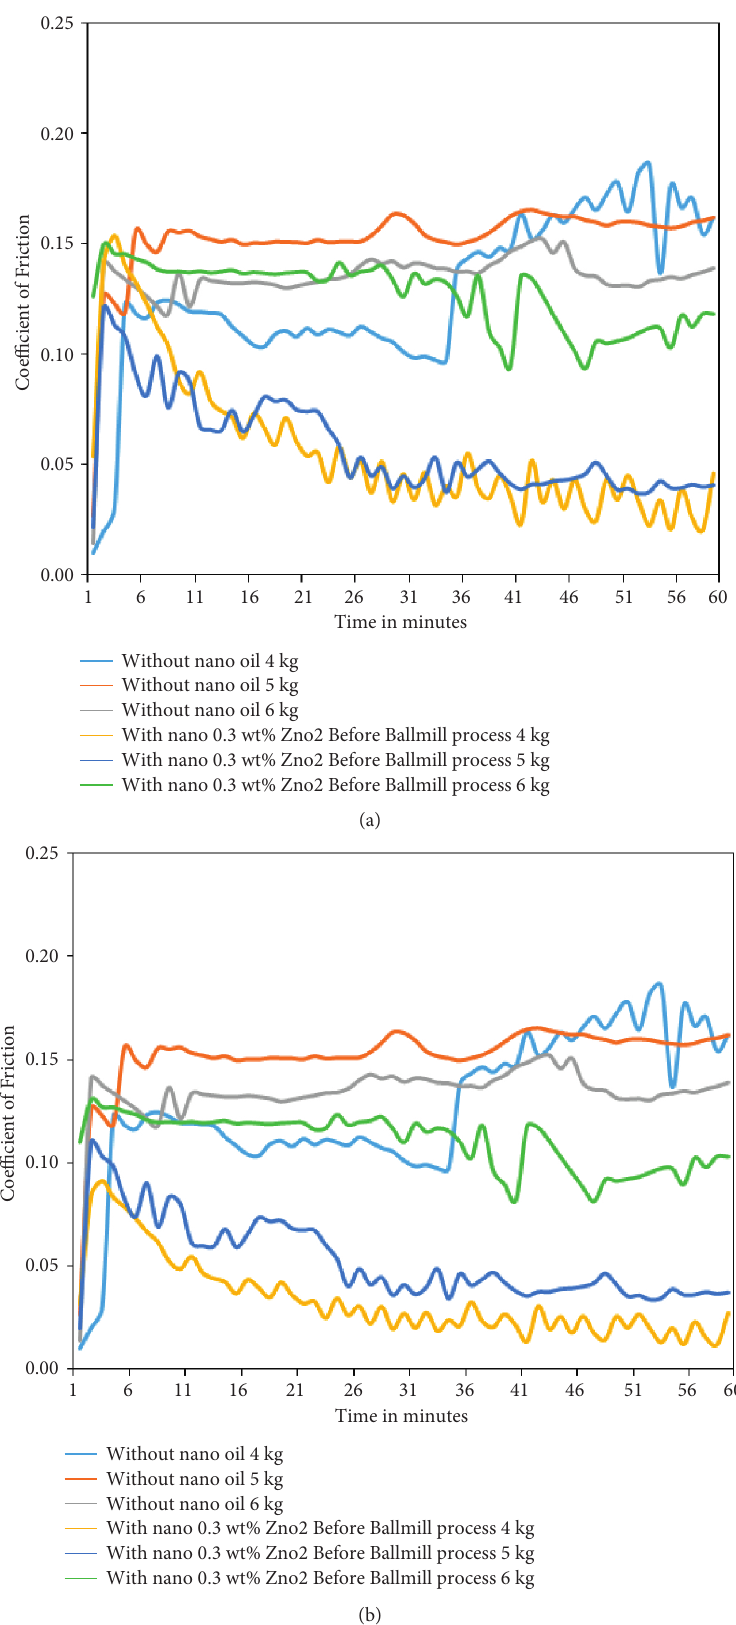
Figure 5: (a) Coefficient of friction values of NPDP with 0.3 wt. % unmilled nanoparticles. (b) Coefficient of friction values of NPDP with 0.3 wt. % ball-milled